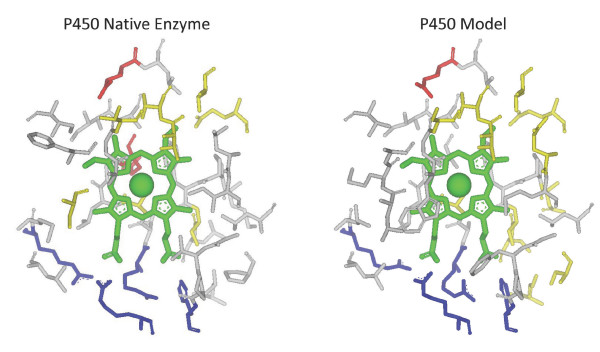
Comparison of the residues constituting ACT_CENT in cytochrome P450 2B4 and a model generated in a recapitulation experiment. In the left panel, the active site of cytochrome P450 (1po5) is plotted; in the right panel, the active site of the best model generated by TransCent is shown. The RMSD of the 23 recapitulated residues is 1.0 Å. Color code of side chains, which are depicted as sticks: (Arg, His, Lys), blue; (Asp, Glu), red; (Asn, Cys, Gln, Ser, Thr, Tyr), yellow. Hydrophobic resides are plotted in grey, the heme group is shown in green. Fig. 5 and 6 were created using Accelrys DS Visualizer 2.0 .